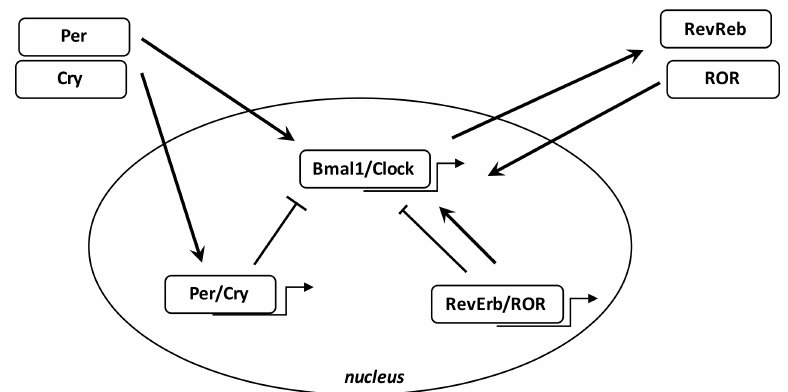
Figure 3. Circadian clock genes. The clock consists of a stimulatory circle, with the Bmal1 / Clock heterodimer activating the transcription of Per and Cry genes, and an inhibitory feedback circle with the Per / Cry heterodimer translocating to the nucleus and repressing the transcription of the Clock and Bmal1 genes. An additional circle involves the RORs and RevErbs factors with a positive feedback by ROR and a negative feedback by